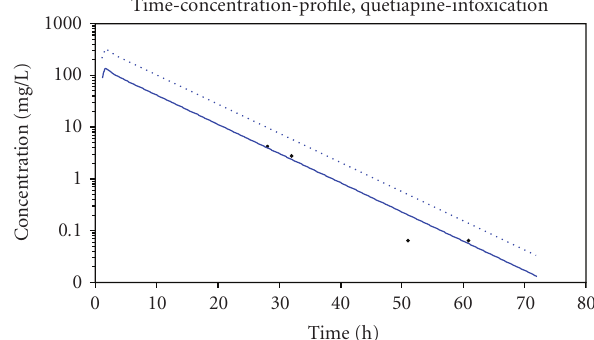
Figure 1: Serum time-concentration profile of quetiapine after ingestion of an assumed amount of 36g Seroquel in a 32-year-old female patient. Solid-line: fitted line based on a two-compartment model assuming a reduced resorption. Dotted line: fitted line expected by population pharmacokinetic parameters and normal